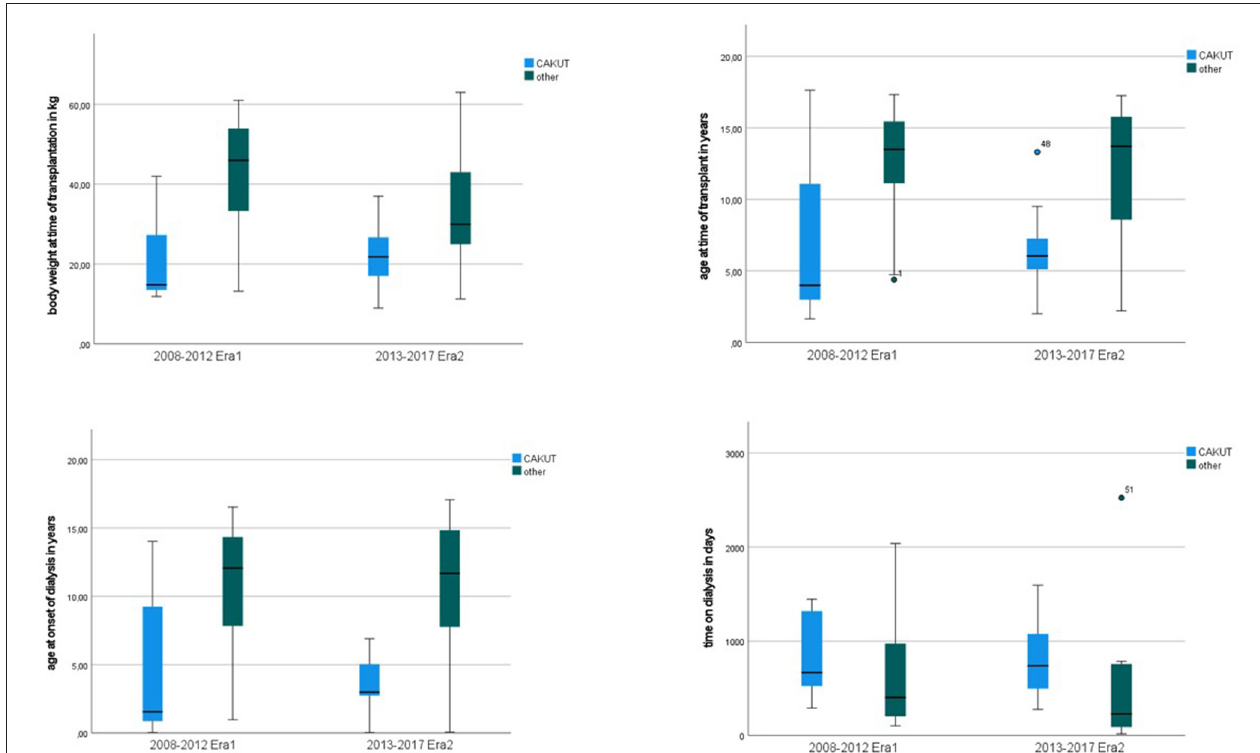
FIGURE 3 | Recipients age at onset of dialysis and at time of transplant according to primary